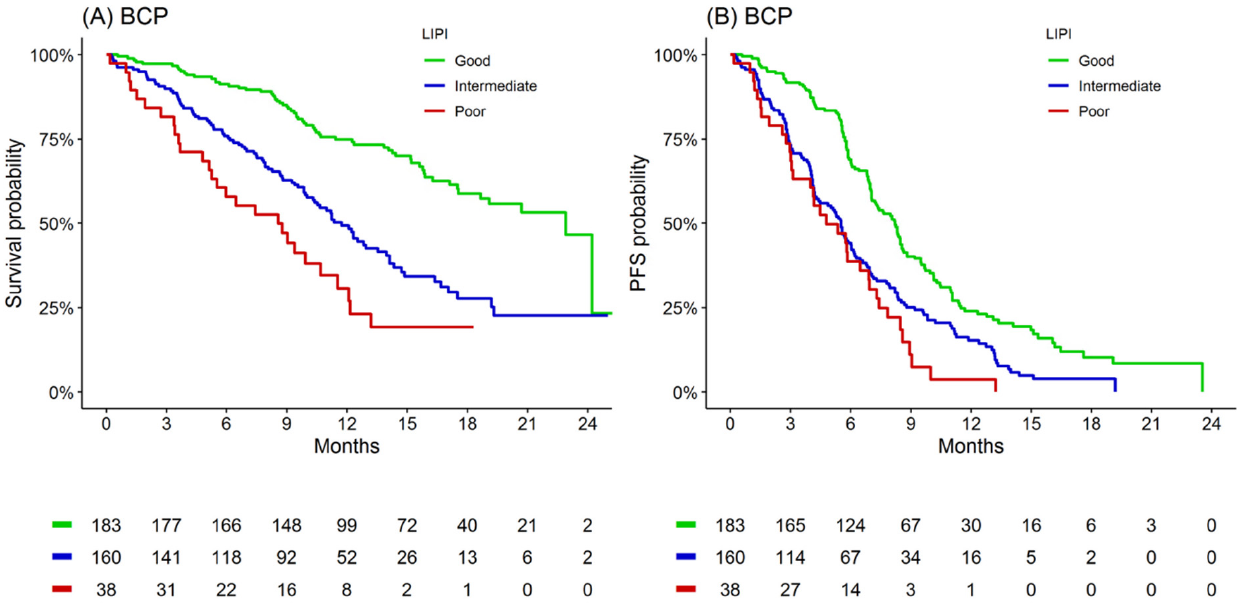
Figure 1. Kaplan-Meier estimates of overall survival and progression-free survival according to LIPI group for patients treated with BCP. ( A ) Overall survival and ( B ) progression-free survival.